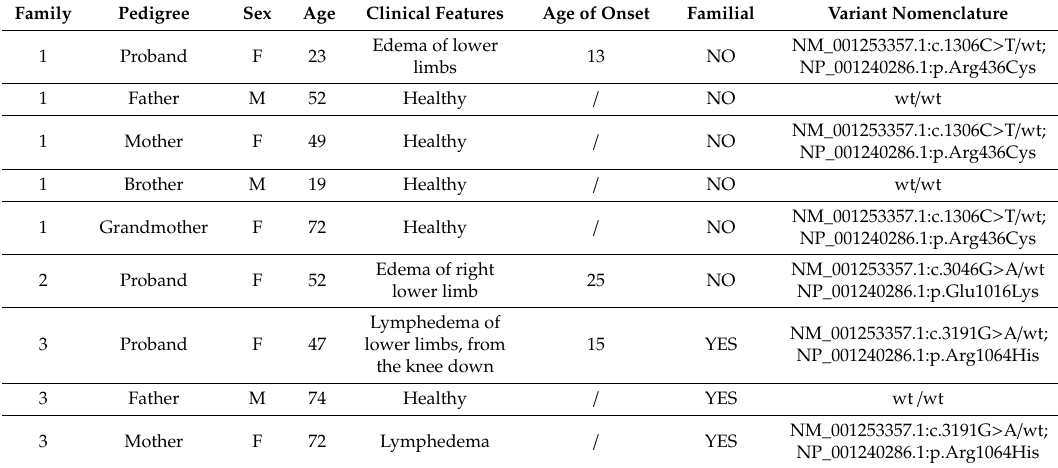
Table 2. Clinical features of probands with TIE1 variants.